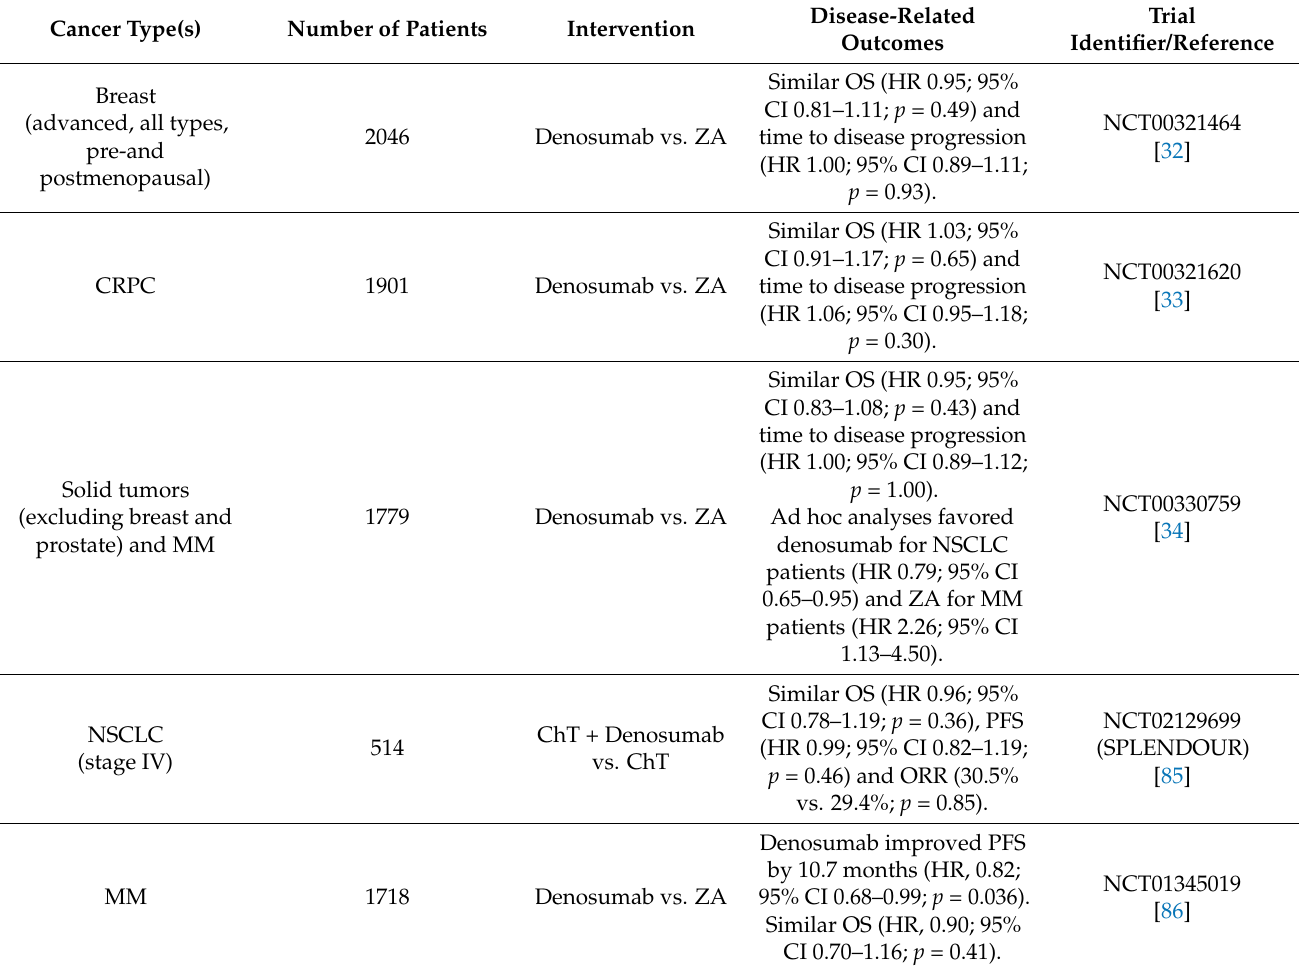
Table 2. Randomized controlled trials of denosumab disease-modifying properties in advanced human cancer. Cancer